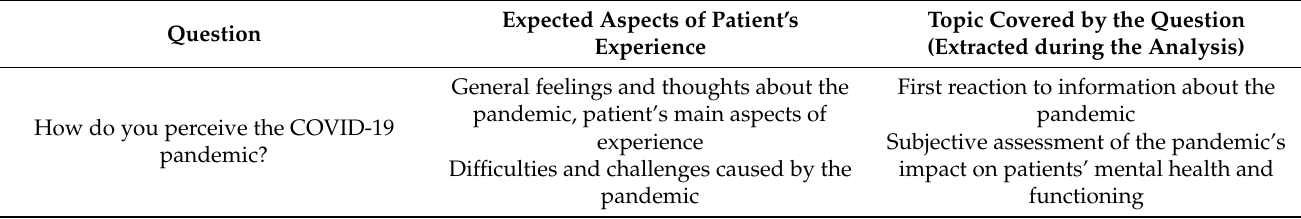
Table 1. Interview questions concerning the pandemic